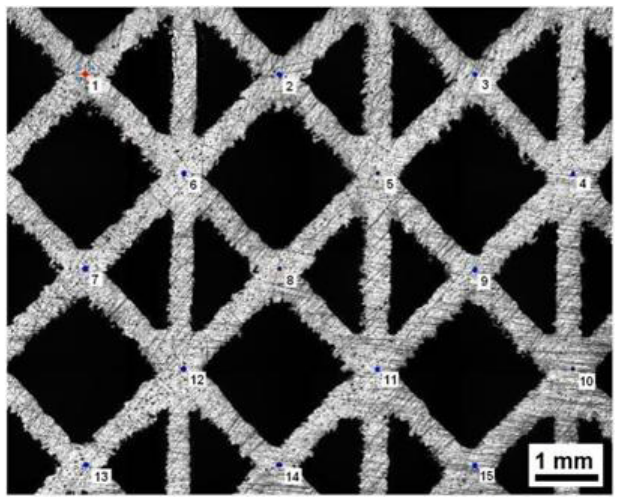
Figure 4. Truss thickness measured via